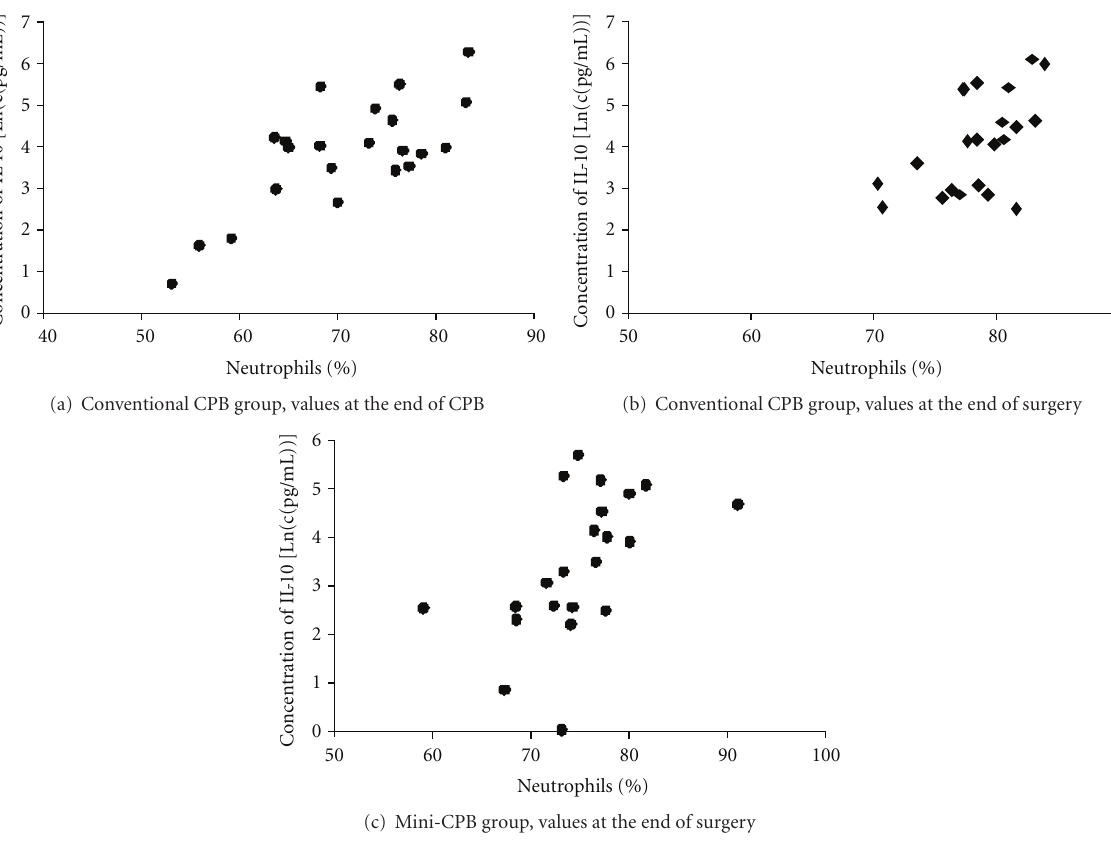
Figure 3: Relationship between percentage of neutrophils and serum level of IL-10. (a) Correlation, r s = 0 . 73, in conventional CPB group at the termination of CPB ( P < 0 . 001). (b) Correlation, r s = 0 . 54, in conventional CPB group at the end of surgery ( P < 0 . 01). (c) Correlation, . 54, in mini-CPB group at the end of surgery ( P < 0 . 01) r s = 0 Table 2: IL-10 level in groups of patients without and with organ dysfunction or